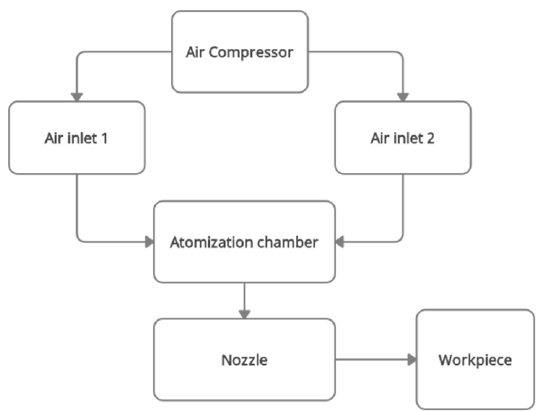
Figure 1. Flow diagram of the bubble-bursting MQL system.